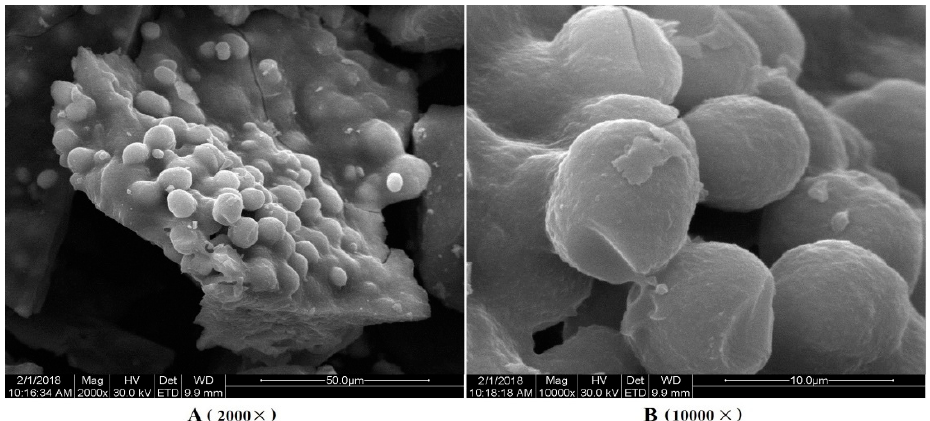
Figure 4. Molecular morphology images of Se-TP: ( A ) at magnifications of 2000 × , and ( B ) at magnifications of 10,000 × . The diameter of the spherical particles was approximately 5 µ m and the surface was smooth.